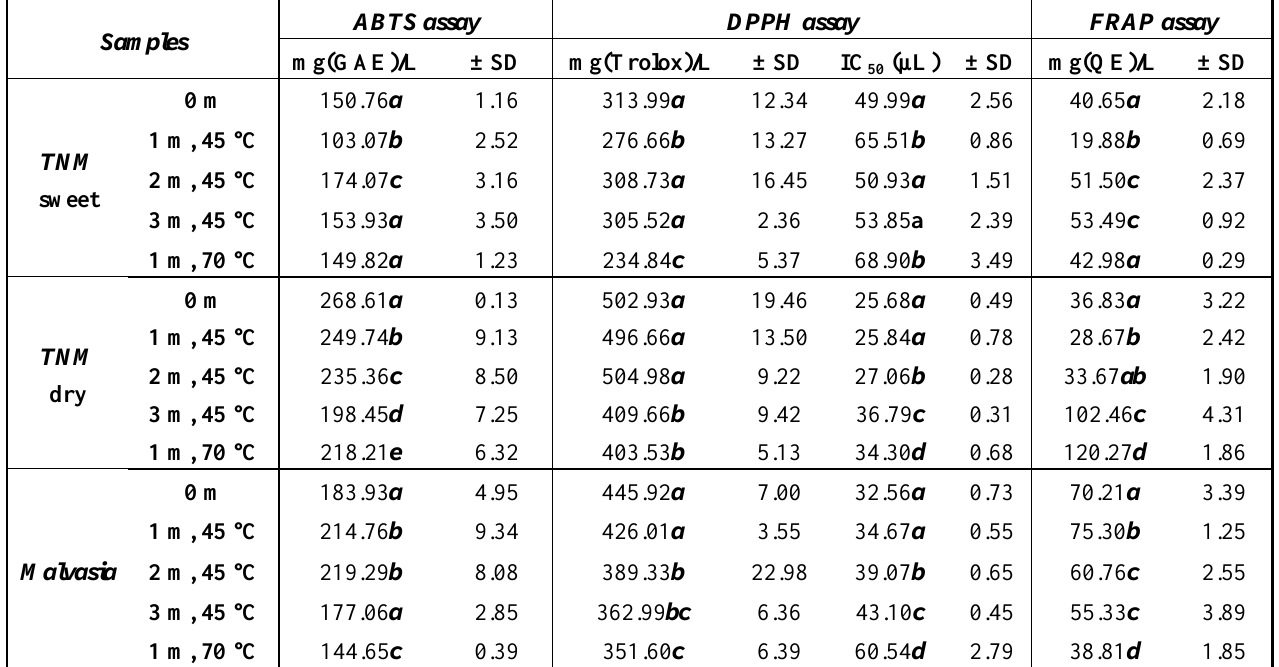
Table 6. Antioxidant potential of Madeira wines during the heating at 45 °C (3 months) and 70 °C (1 month) expressed in terms of ABTS, DPPH and FRAP